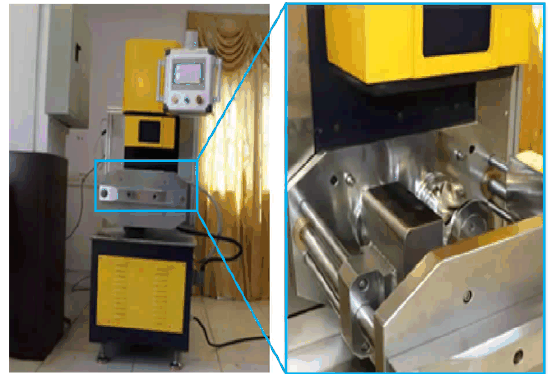
Figure 1. The opening and closing mixer.